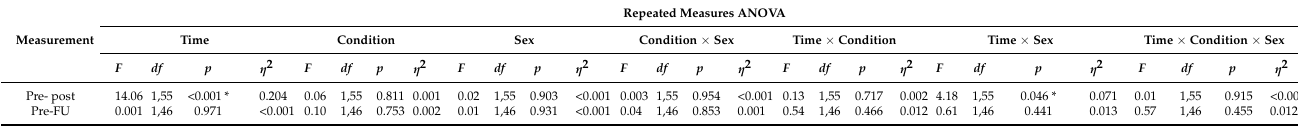
Table 4. Effects of the intervention on cortisol